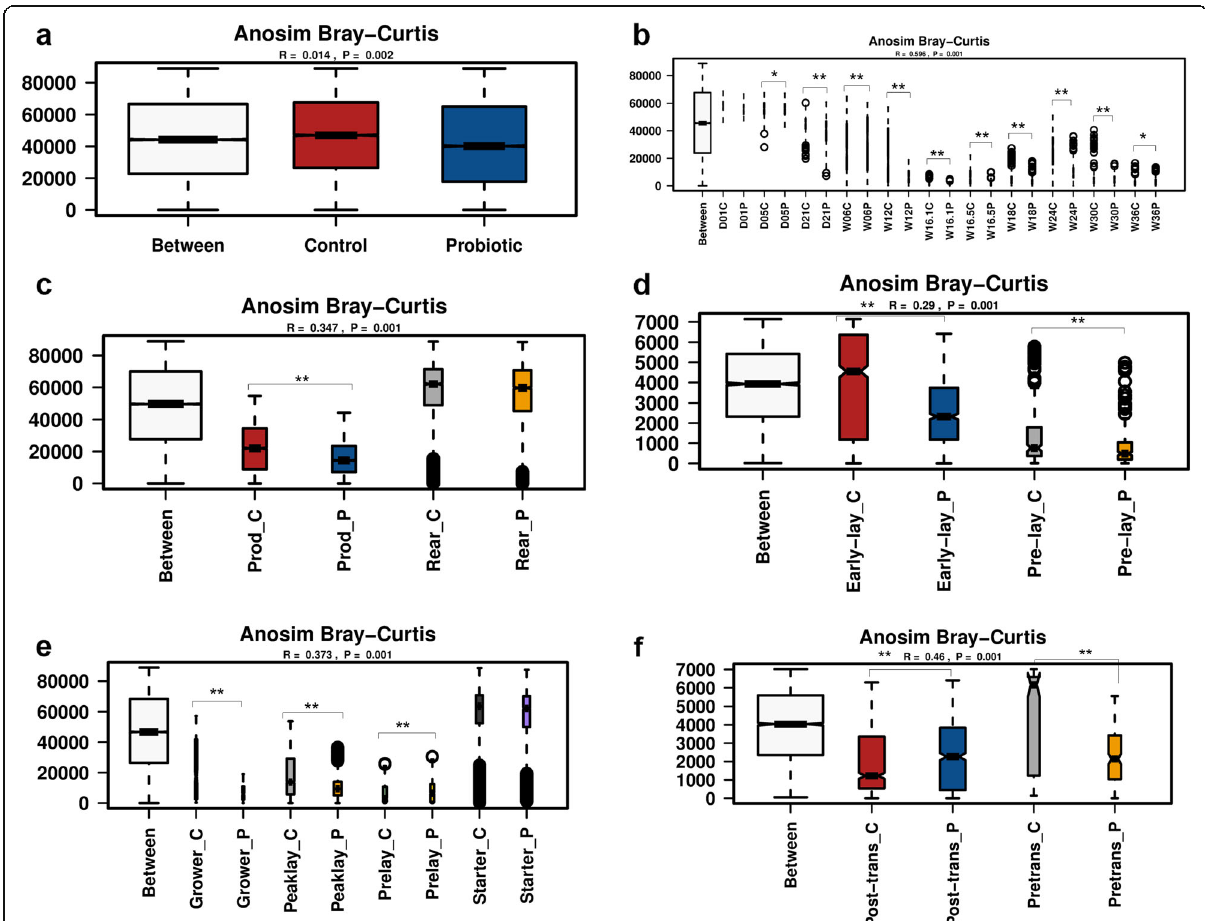
Fig. 7 Beta diversity of gut microbiota of laying chickens affected by probiotic supplementation, flock age and rearing conditions. a) . Overall beta diversity of probiotic and control flocks. b) . Beta diversity affected by flock age. c) . Beta diversity affected by the probiotic supplementation in the rearing (Rear) and production (Prod) phases of laying chickens. d) . Beta diversity affected by the probiotic supplementation in the Pre-lay and Early-lay phases of laying chickens. e) . Beta diversity affected by the feeding regimen. f) . Beta diversity affected by transportation stress. Within each treatment group, “ C ” refers to control, while “ P ” refers to the probiotic supplemented flocks. Beta diversity was measured at genus level by ANOSIM Bray-Curtis dissimilarities matrix in Calypso software. Asterisks (**) show P value at 0.001 between the respective two treatment